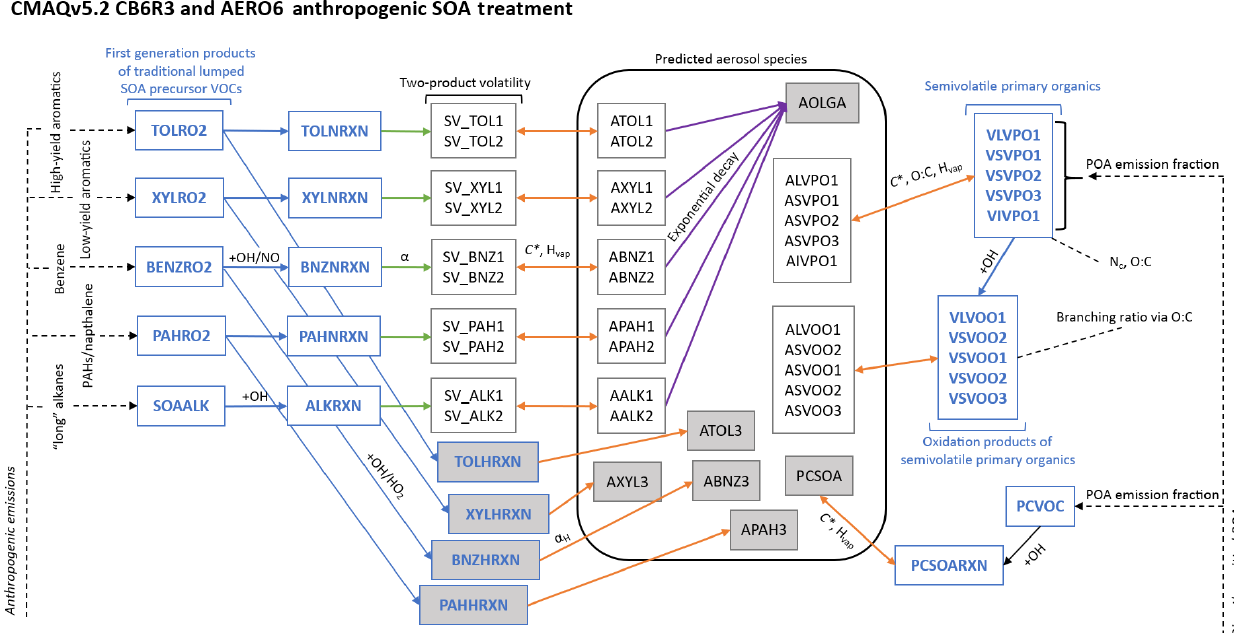
Figure 4. Treatment of anthropogenic SOA in CMAQv5.2. Predicted aerosol species are included in the black box. Species in white boxes are semivolatile and species in gray boxes are nonvolatile. Blue indicates species and processes predicted by CB6R3. All other coloring indicates the AERO6 mechanism where green arrows are two-product volatility distribution, orange arrows are particle- and vapor-phase partitioning, and purple arrows are oligomerization. In AERO6, anthropogenic and biogenic VOC emissions (lumped by category) are oxidized by OH, NO, and HO 2 and OH, O 3 , NO, and NO 3 respectively, to semivolatile products that undergo partitioning to the particle phase (Pye et al., 2015). Semivolatile primary organic pathways in CMAQv5.2 are described by Murphy et al. (2017).